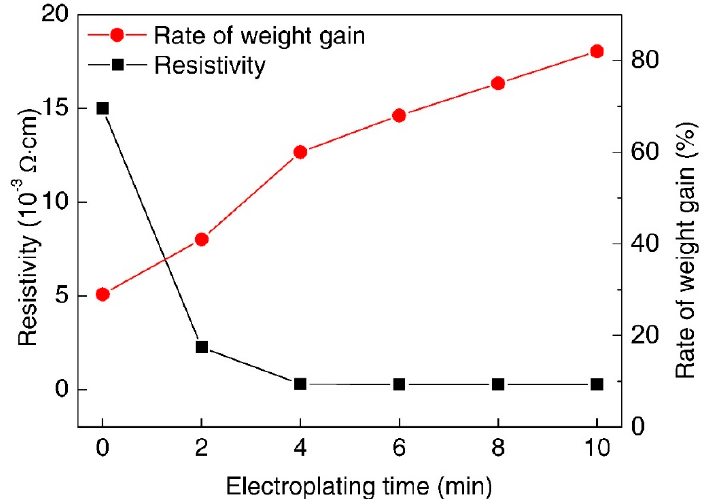
Figure 5. Influence of electroplating time on resistivity and the rate of weight gain.